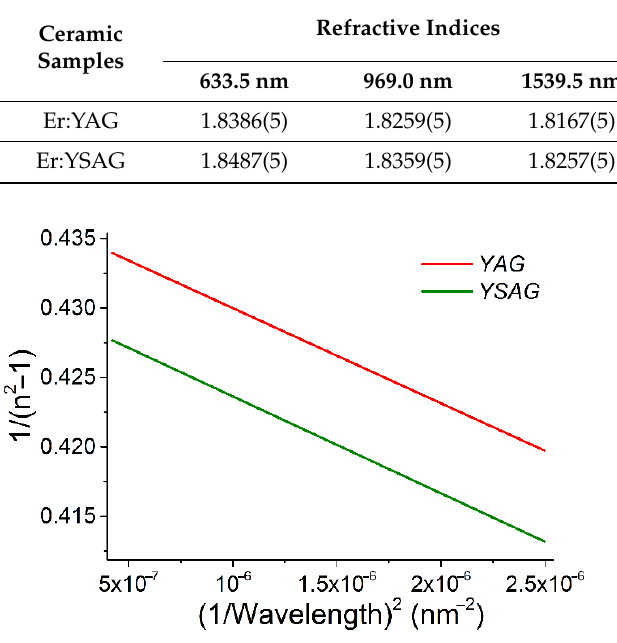
Figure 2. Refractive index (n) –wavelength (λ) dependence.